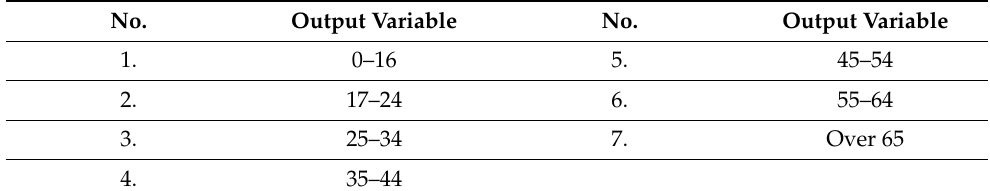
Table 1. Output variable for constructing the predictive model. No. Output Variable